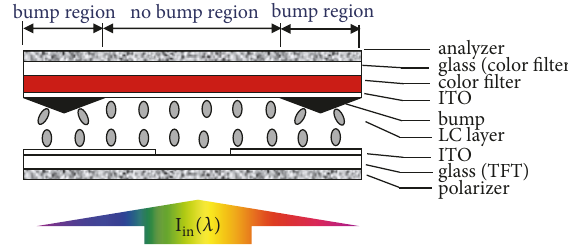
Figure 1: Scheme of MVA liquid crystal module.